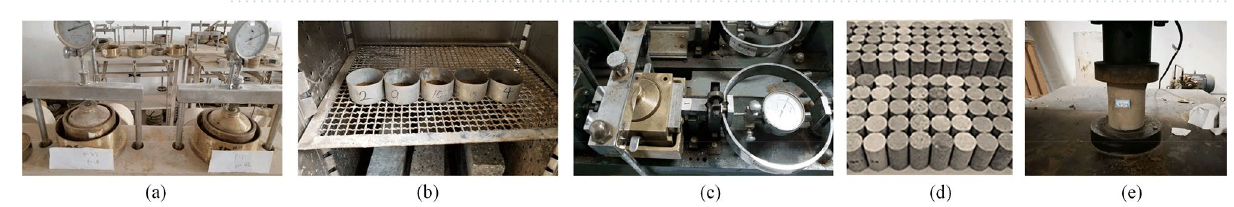
Figure 14. Physical property tests: ( a ) oedometer test; ( b ) moisture content test; ( c ) direct shear test; ( d ) specimens with different proportions; ( e ) compression tests.